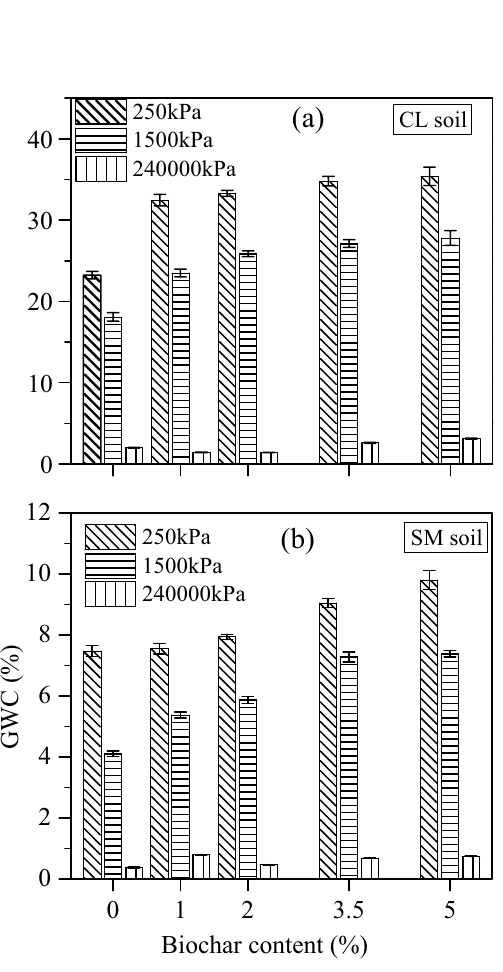
Figure 9. Variation of gravimetric water content (GWC) of ( a ) CL, and ( b ) SM soil; with the increment of biochar content (from 0 to 5% (w/w)) at 250 kPa, 1500 kPa and 240,000 kPa suction